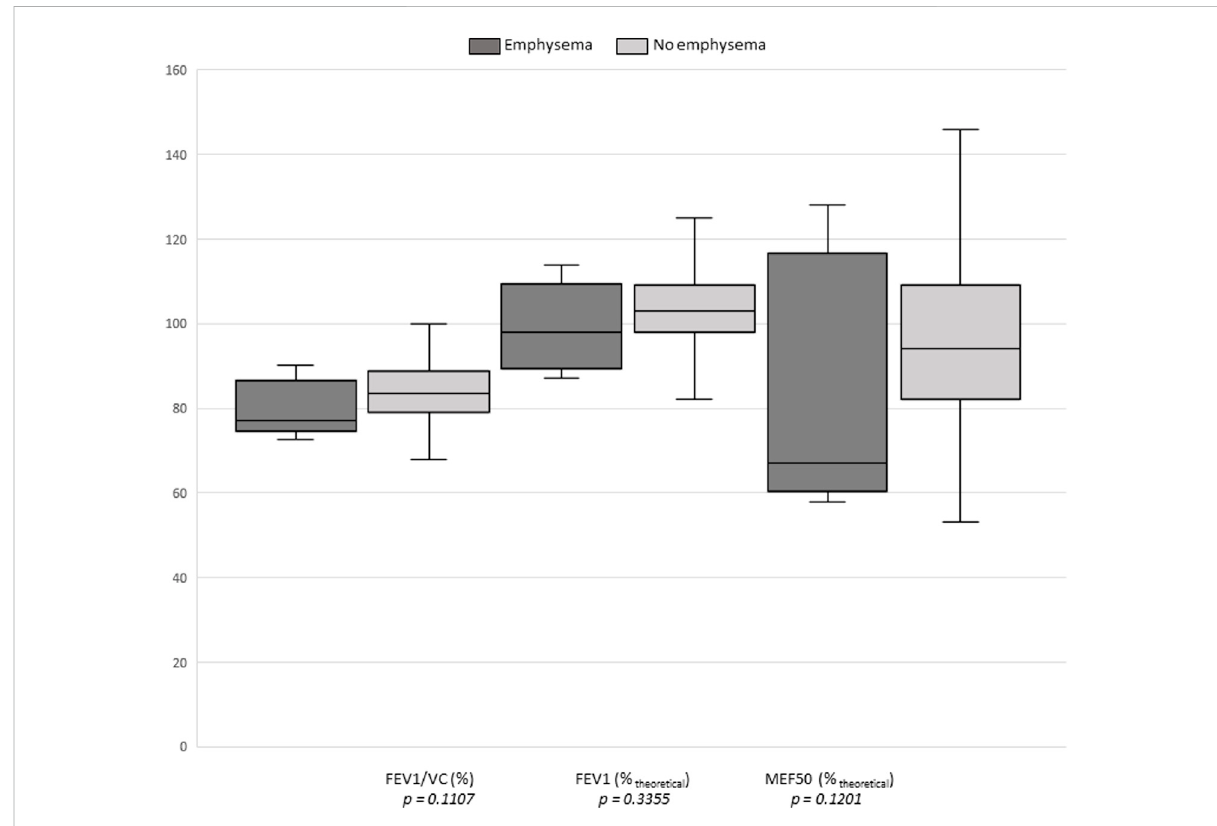
FIGURE 4 Graphical representation of the comparison between a CT scan emphysema result and the three spirometry